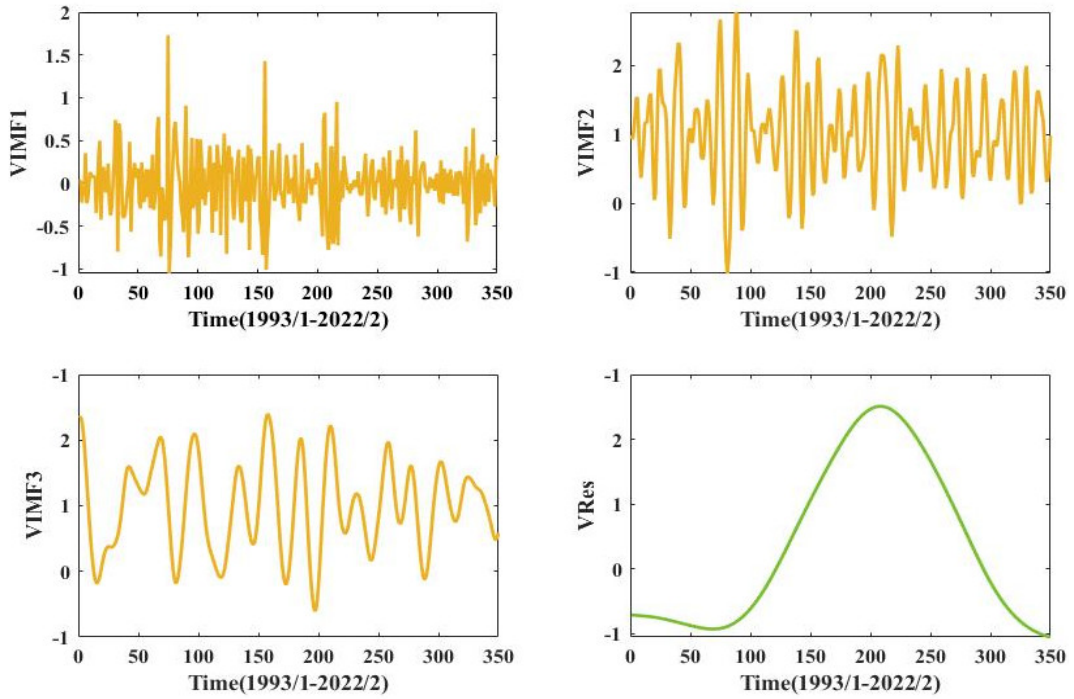
Figure 7. VMD decomposition results.